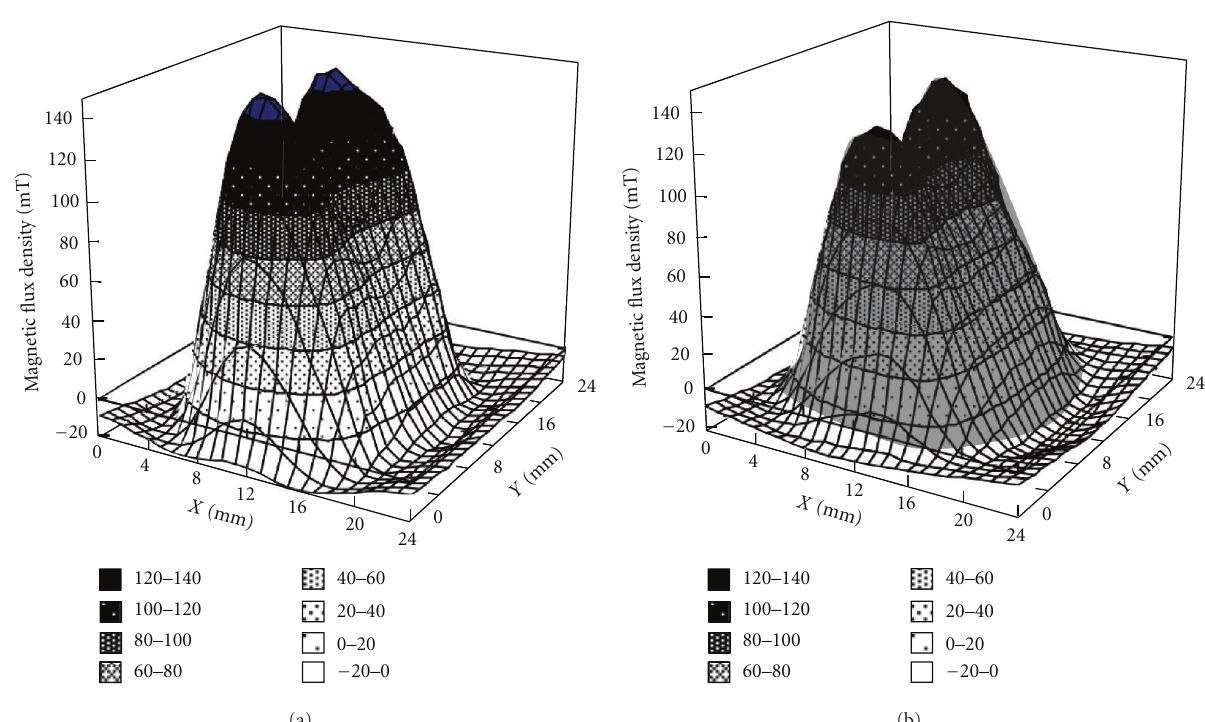
Figure 16: Distribution of magnetic flux density after the magnetization in the same